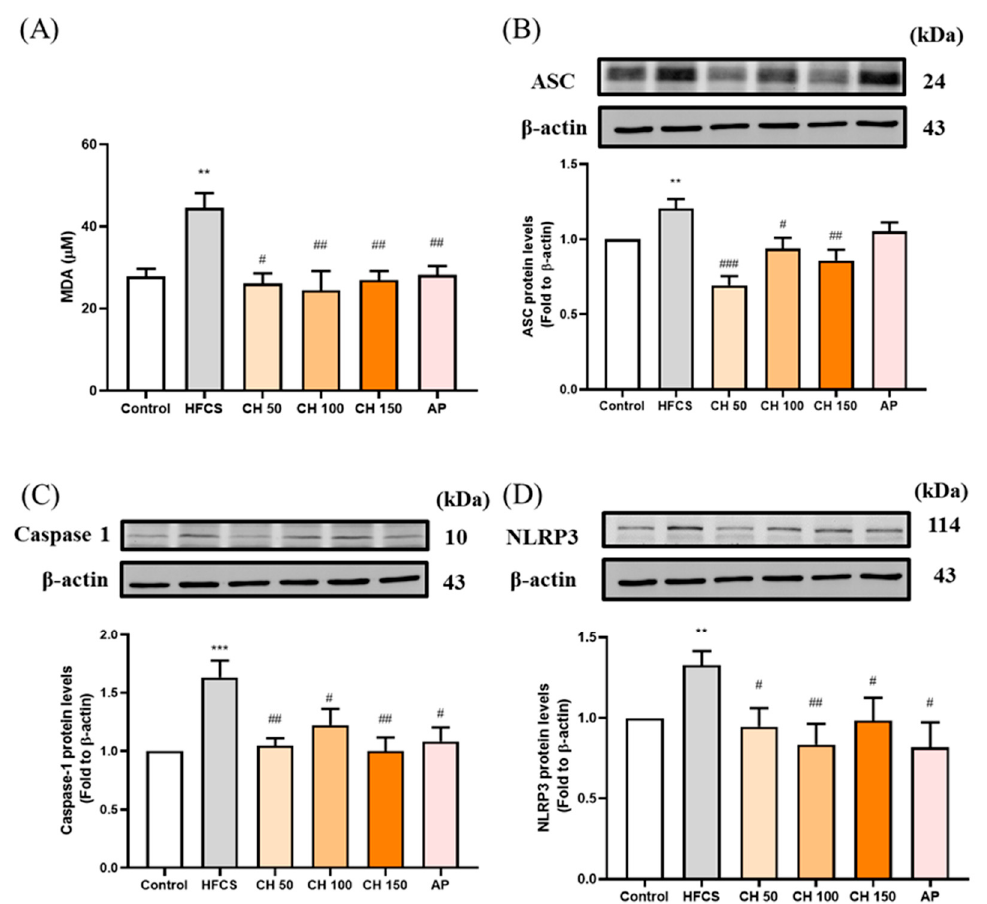
Figure 6. Effects of chrysin on oxidative inflammasome-activation ( A ) serum malondialdehyde (MDA) level and inflammasome protein expression of ( B ) ASC, ( C ) caspase-1, and ( D ) NLRP3 in the kidney of hyperuricemic rats. C: control; HFCS: high-fructose corn syrup group (10% high-fructose corn syrup solution); CH 50: chrysin (50 mg/kg bw); CH 100: chrysin (100 mg/kg bw); CH 150: chrysin (150 mg/kg bw). Data are represented as mean ± SEM ( n = 4–6 per group). ** p < 0.01, *** p < 0.001 versus the control group. # p < 0.05, ## p < 0.01, ### p < 0.001 versus the HFCS group.